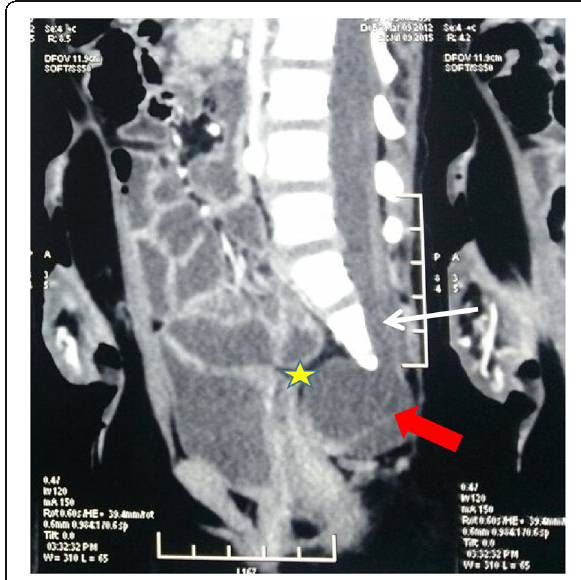
Fig. 1 CECT pelvis (sagittal view) showing the cystic lesion [red arrow] continuous with the spinal CSF space with cord tethering [white arrow] consistent with myelomeningocele and anteriorly compressed rectum [yellow asterisk]